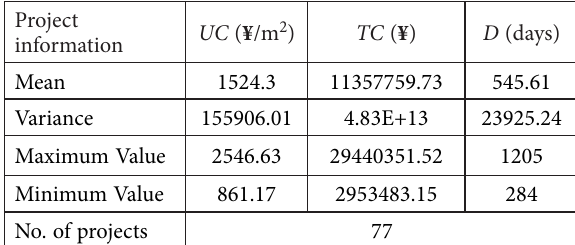
Table 1. Statistics of project cost and